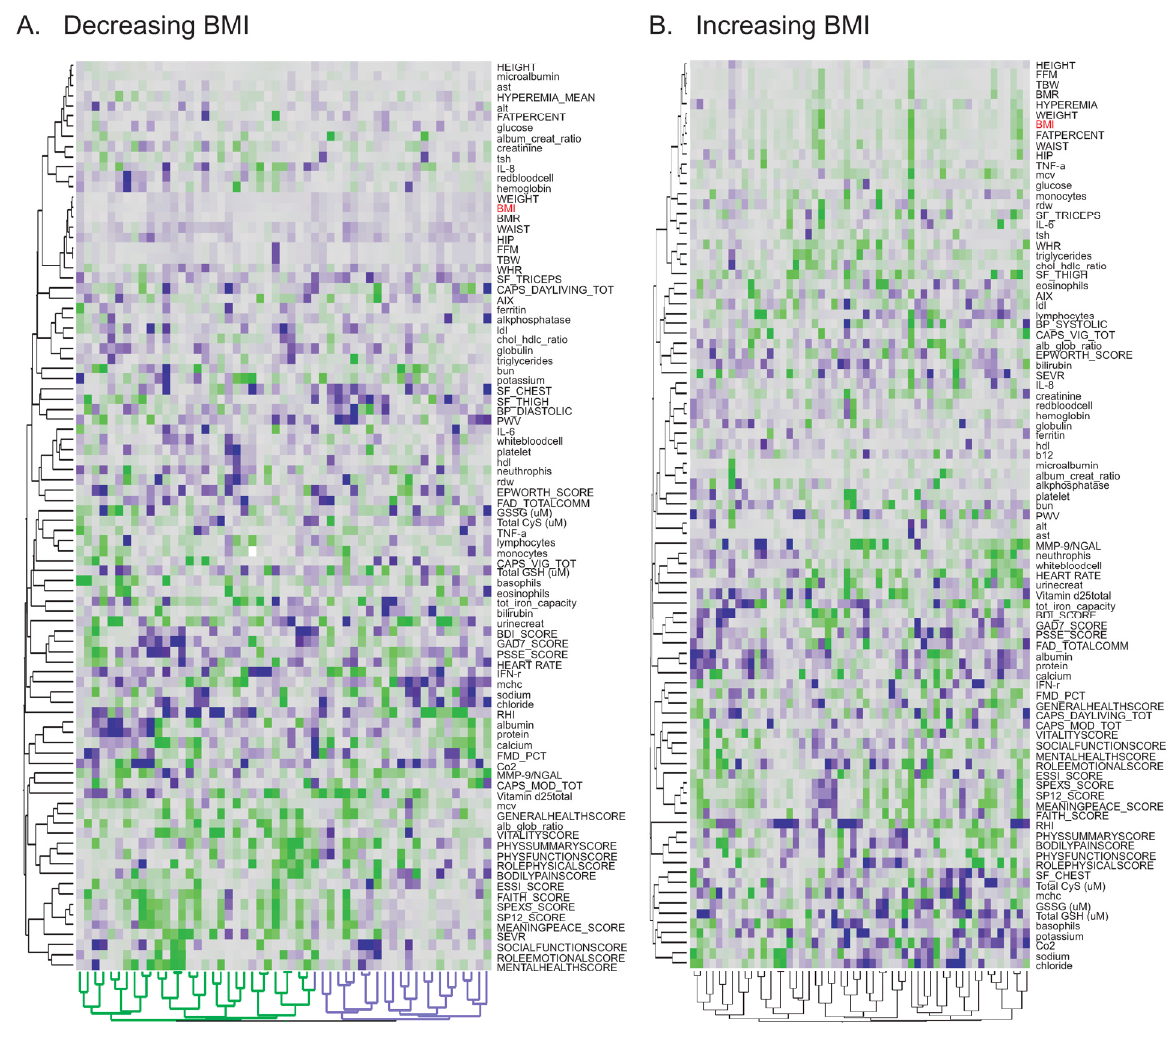
Figure 5. Two-way hierarchical clustering of 91 traits. ( A ) Clustering based on Ward’s method for 53 people whose BMI reduced (slope less than − 0.023 over first three visits), showing two main groups of 30 people whose general health scores improve (positive slopes, green) and 23 people who do not show any common trends for other traits; ( B ) Clustering for 53 people whose BMI increased (slope greater than 0.023 over first three visits), showing no strong